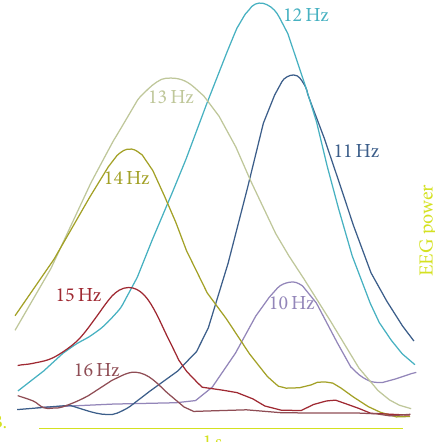
Figure 1: The intraspindle frequency variation. Averaged (60 EEG sensors) spatiotemporal evolution of different frequency during an example spindle. Power in different frequencies is color coded (warmer colors are higher frequencies). Modified from